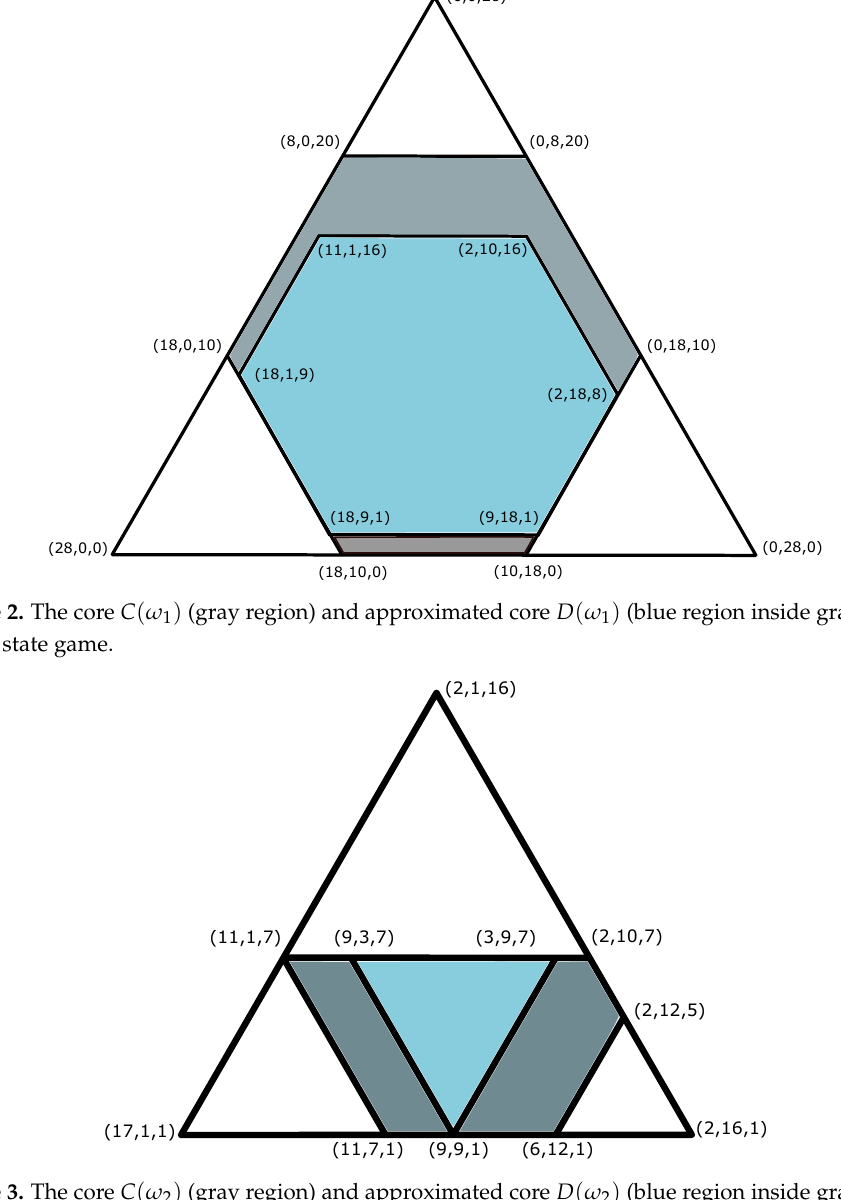
Figure 3. The core C ( ω 2 ) (gray region) and approximated core D ( ω 2 ) (blue region inside gray region) for ω 2 state